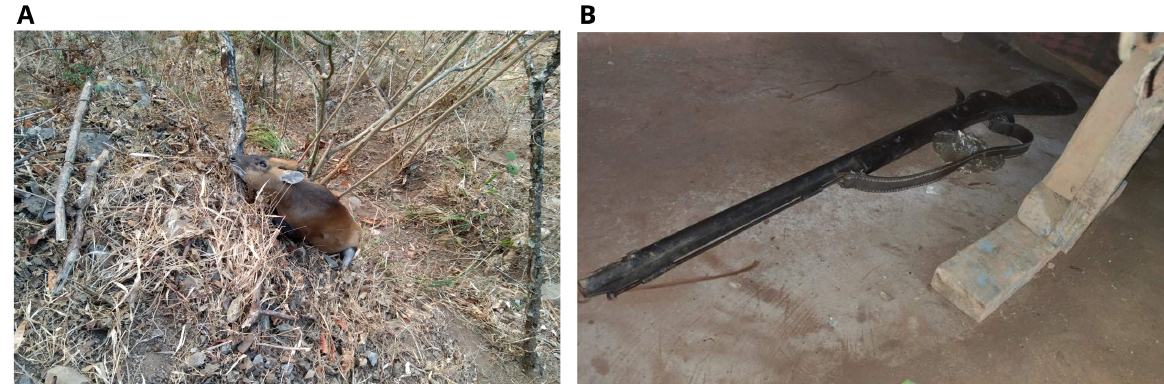
Figure 2. Dead barking deer ( A ) and the gun used for hunting ( B ).